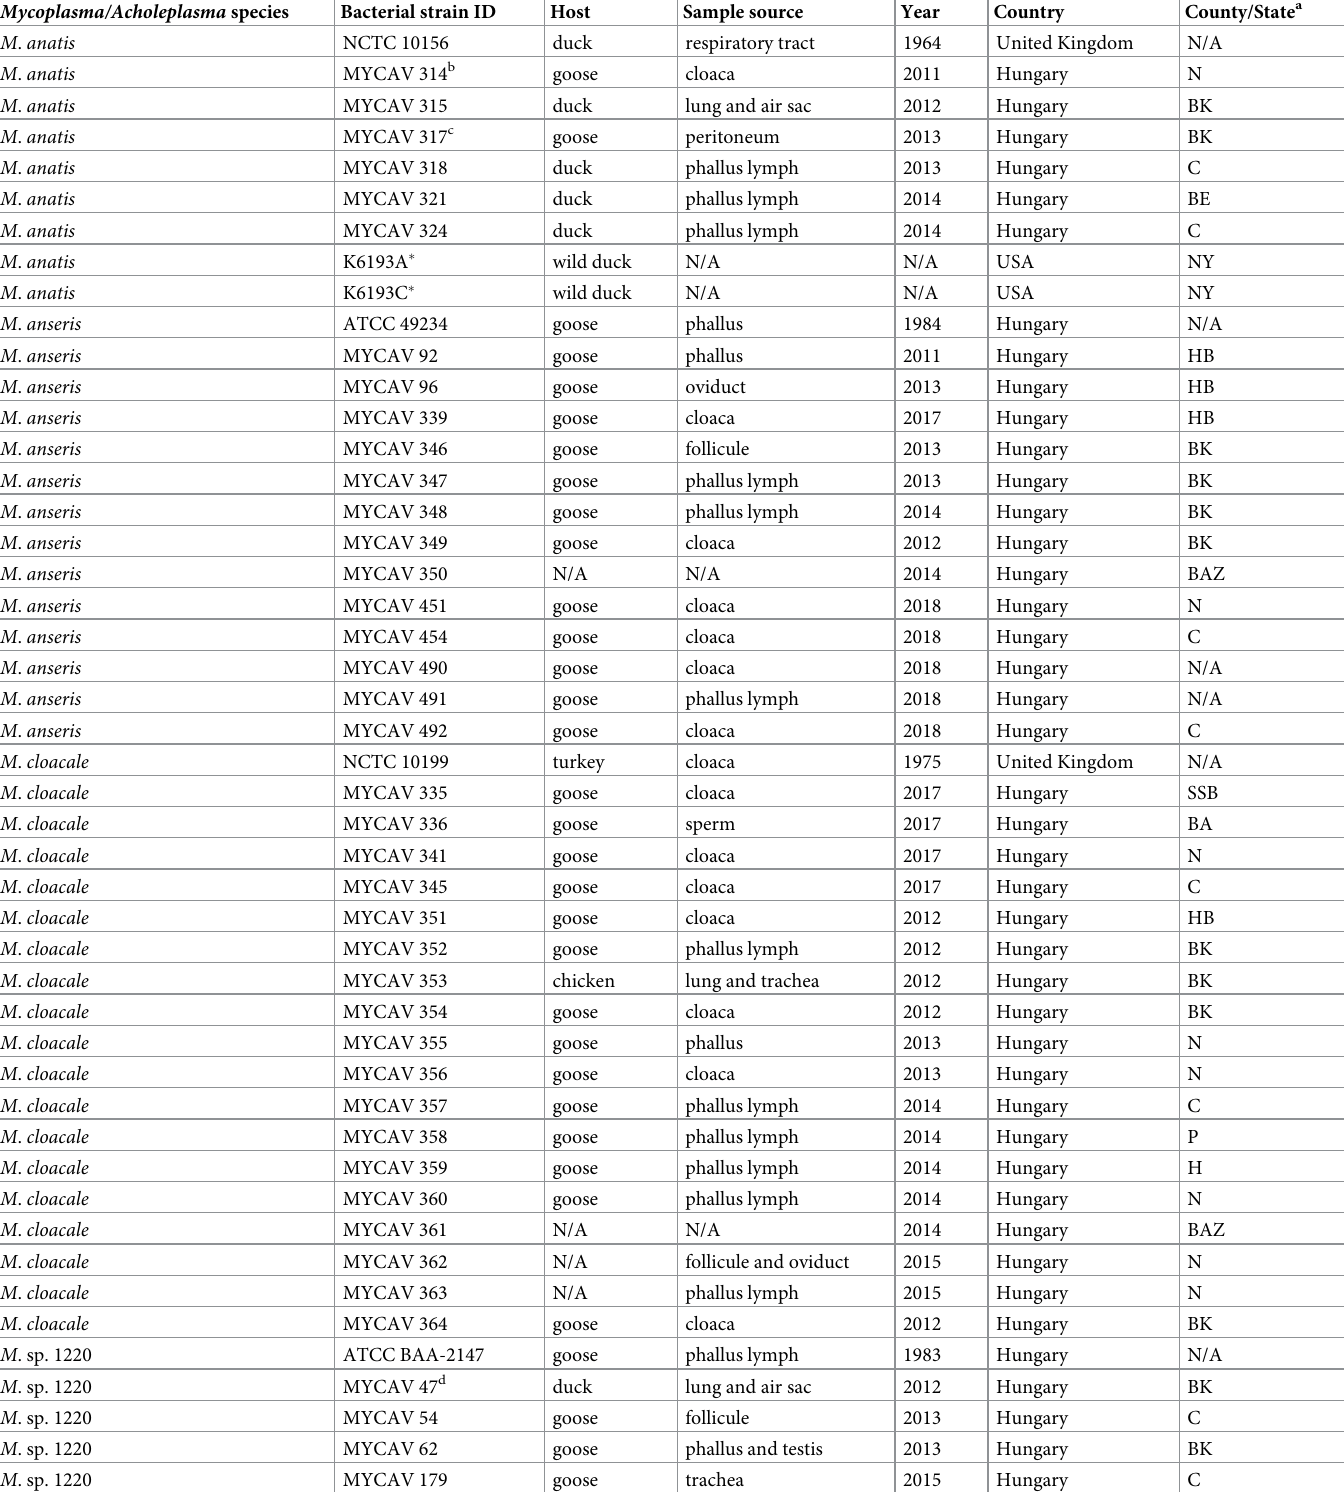
Table 1. Mycoplasma and Acholeplasma isolates/strains used in this study. Mycoplasma/Acholeplasma